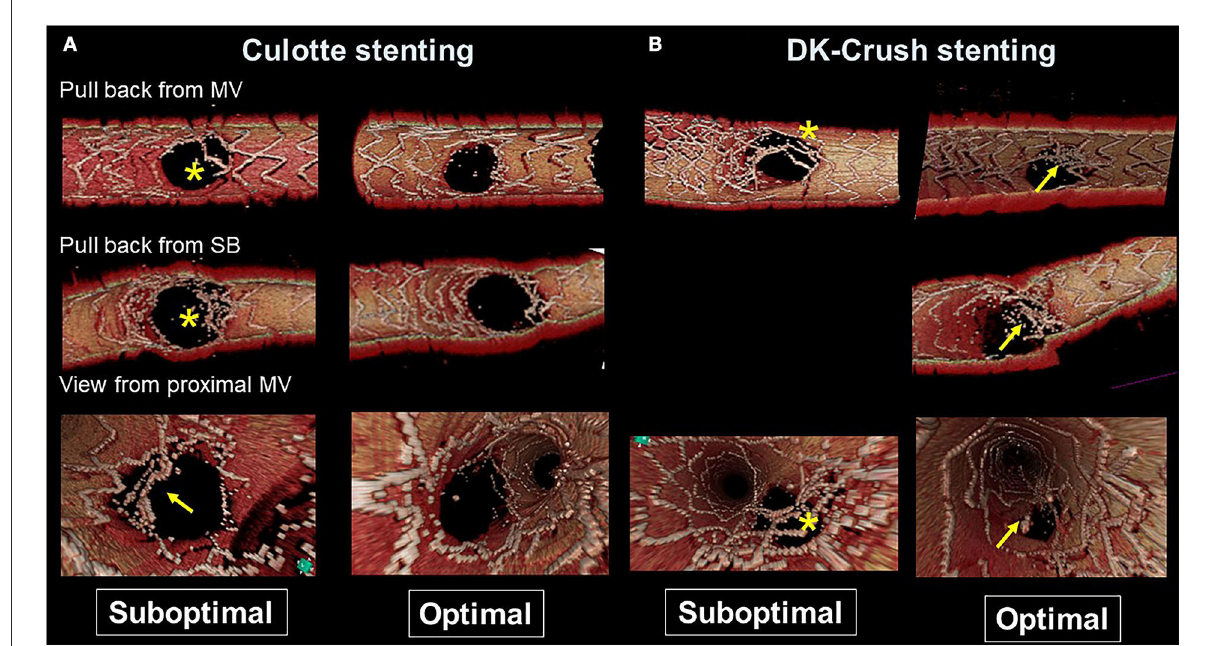
FIGURE5 Representative optimal and suboptimal cases of 2-stent on 3D optical coherence tomography (OCT) assessment. (A) Culotte stenting. In a suboptimal case (left column), metallic carina remains (asterisks in pullback views from the main vessel [MV] and side branch [SB]) and there is insufficient stent expansion in the main branch ostium with malapposed strut at the lateral site (arrow in the view from proximal MV). In an optimal case (right column), both branch ostia are well-expanded with good apposition. (B) Double kissing (DK)-crush stenting. In a suboptimal case (left column) due to suboptimal wiring outside of the hole made by first kissing balloon inflation (KBI), jailing struts remain at the SB ostium (asterisks). In an optimal case (right column), metallic carina remains (arrows), but it is located in a neutral position between both branches and creates no limitation for MV stent expansion or incomplete stent crush.